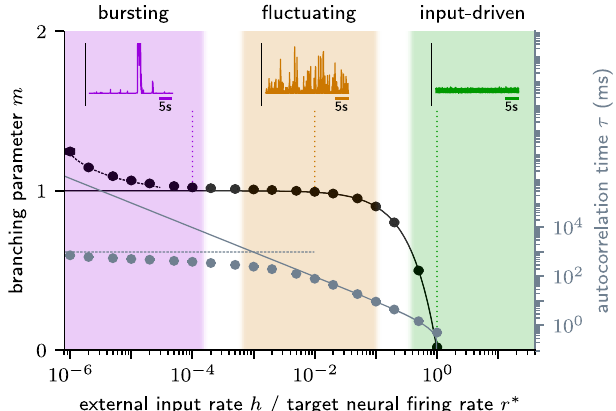
FIG. 6. Sketch of bursting, fluctuating, and input-driven net- work states, classified by the branching parameter and the autocorrelation time. We propose (solid lines) that homeostatic plasticity tunes the dynamic state depending on the ratio of external input rate (including spontaneous neural firing) and target neural firing rate. Data points and example activity traces stem from Erd ő s-R´enyi networks ( N ¼ 10 4 , p ¼ 10 − 1 , 10 3 s). In the bursting regime, the homeostatic timescale τ hp ¼ τ influences the resulting dynamics (dashed hp